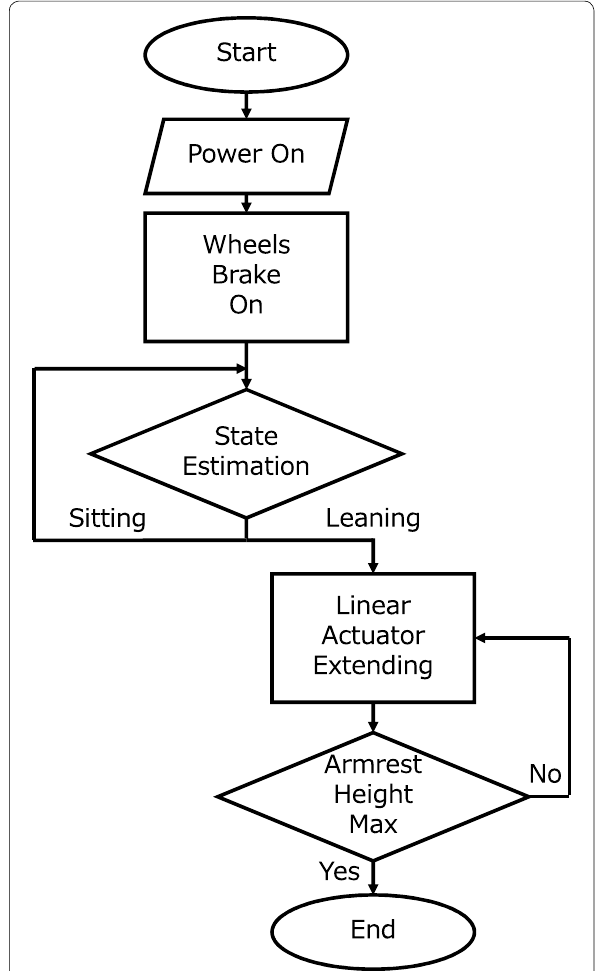
Fig. 3 Flowchart of the developed robot system. The estimation is conducted by a human in the first experiment